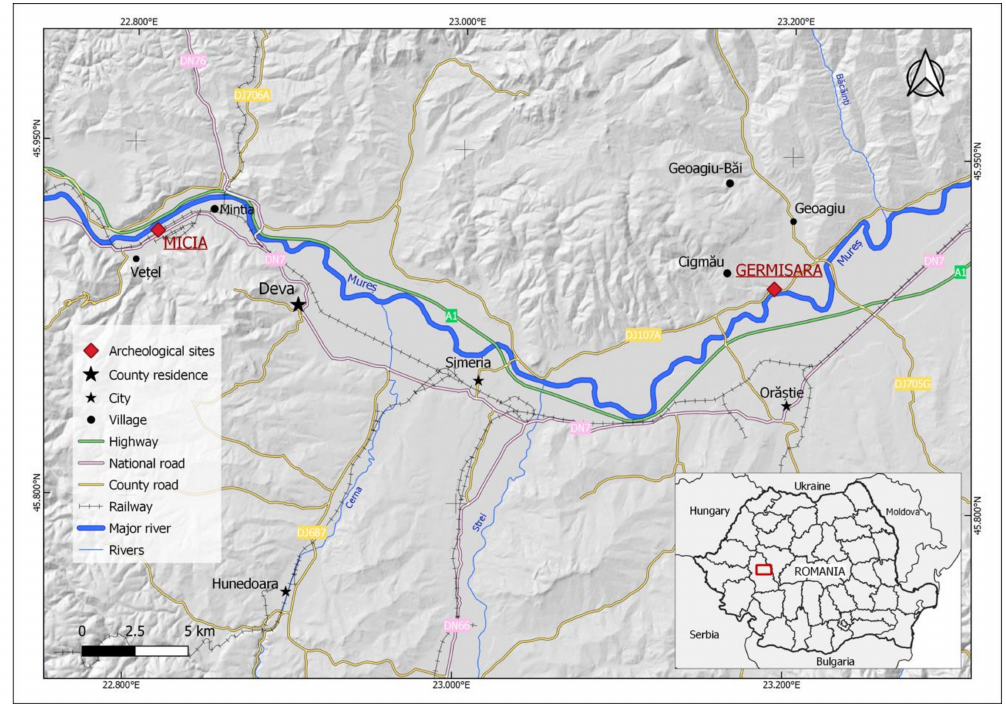
Figure 1. The location of Micia and Germisara archaeological